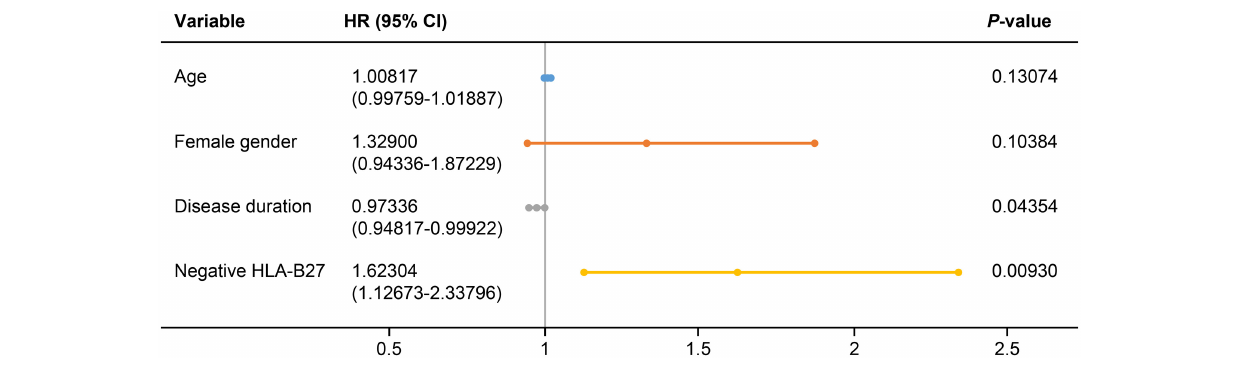
biologic-naïve patients with axial SpA initiating TNFis treatment from 12 registries in the EuroSpA collaboration (20). The study showed that 12-month retention rate was 80% ranging from 71 to 94% across registries. Fabbroni et al. (21) evaluated treatment